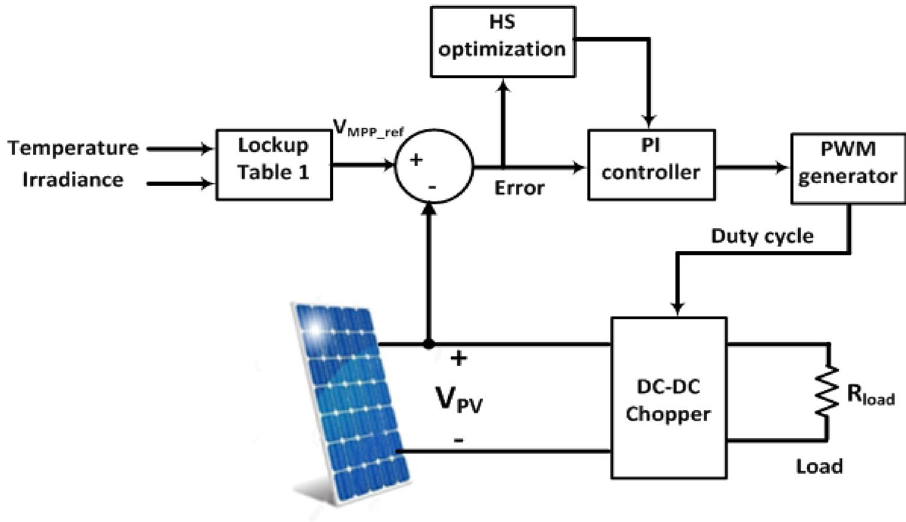
Figure 1. System under study.